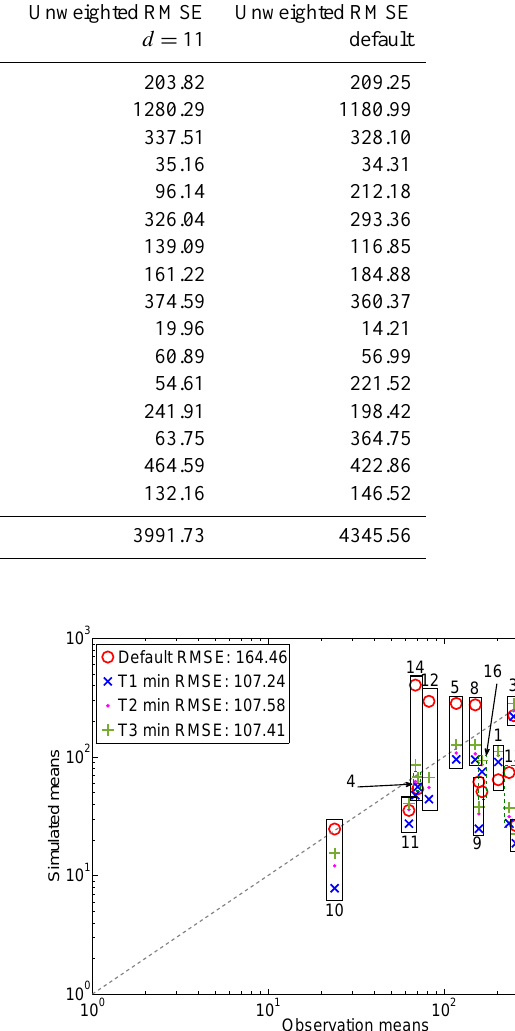
Figure 10. CH 4 emission observations and predictions when using the optimized parameters of optimization trials T1, T2, and T3, re- spectively, and when using the default parameters for the wetland site Salmisuo, Finland, for the real data case with d = 11 parame- ters. The legend shows the lowest RMSE value found in each trial.